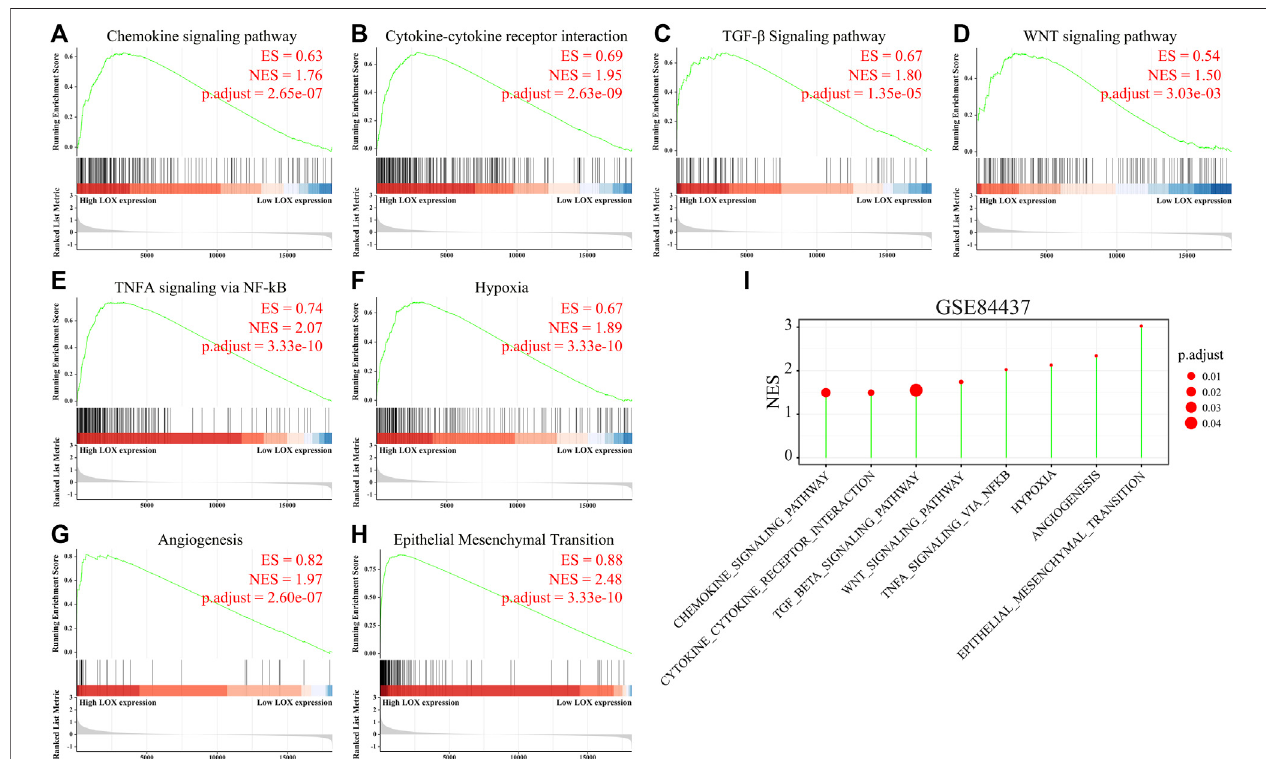
FIGURE 7 | Many pathways associated with M2 macrophage were enriched in the high-LOX-expression group. (A – H) Gene set enrichment analysis (GSEA) of M2 macrophage-related enrichment gene sets in the STAD samples from TCGA database, including chemokine signaling pathway (A) , cytokine – cytokine receptor interaction (B) , TGF- β signaling pathway (C) , WNT signaling pathway (D) , TNF α signaling pathway (E) , hypoxia (F) , angiogenesis (G) , and epithelial – mesenchymal transition (H) . (I) GSEA analysis of M2 macrophage-related enrichment gene sets in the STAD samples from GSE84437 database.